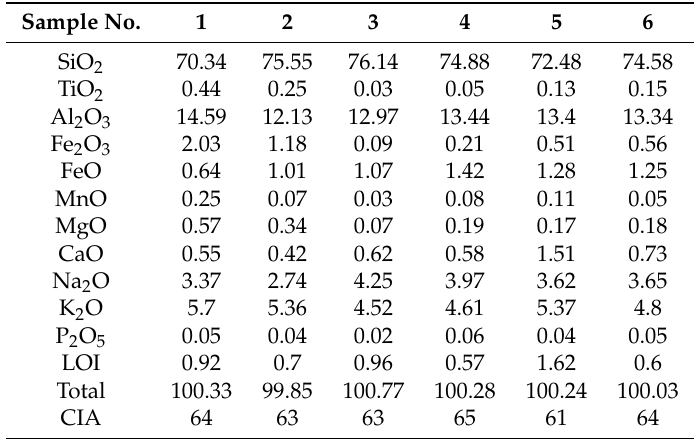
Table 6. Chemical composition (wt %) of Longnan granites (Zudong mining area). Sample